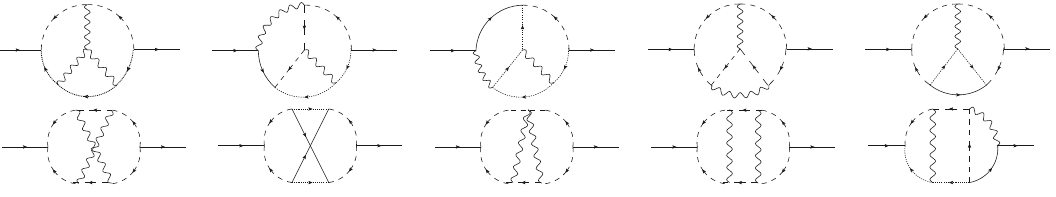
Figure 4 . Three-loop corrections to the scalar